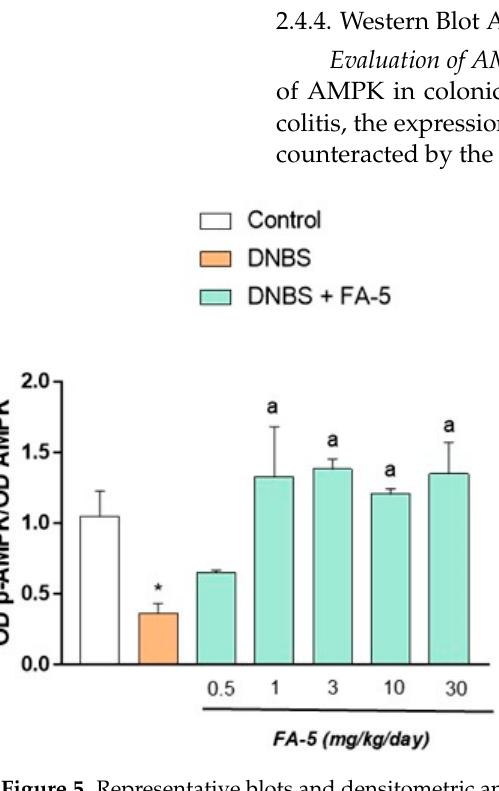
Figure 5. Representative blots and densitometric analysis of the expression of phospho-AMPK and AMPK in colonic tissues from control rats and animals treated with DNBS alone or in combination with FA-5 (0.5, 1, 3, 10, 30 mg/kg/day). Each column represents the mean ± standard error of the mean (SEM) ( n = 6). One-way ANOVA followed by Tukey’s post hoc test results: * p < 0.05, significant difference vs. the control group; a p < 0.05, significant difference vs. the DNBS